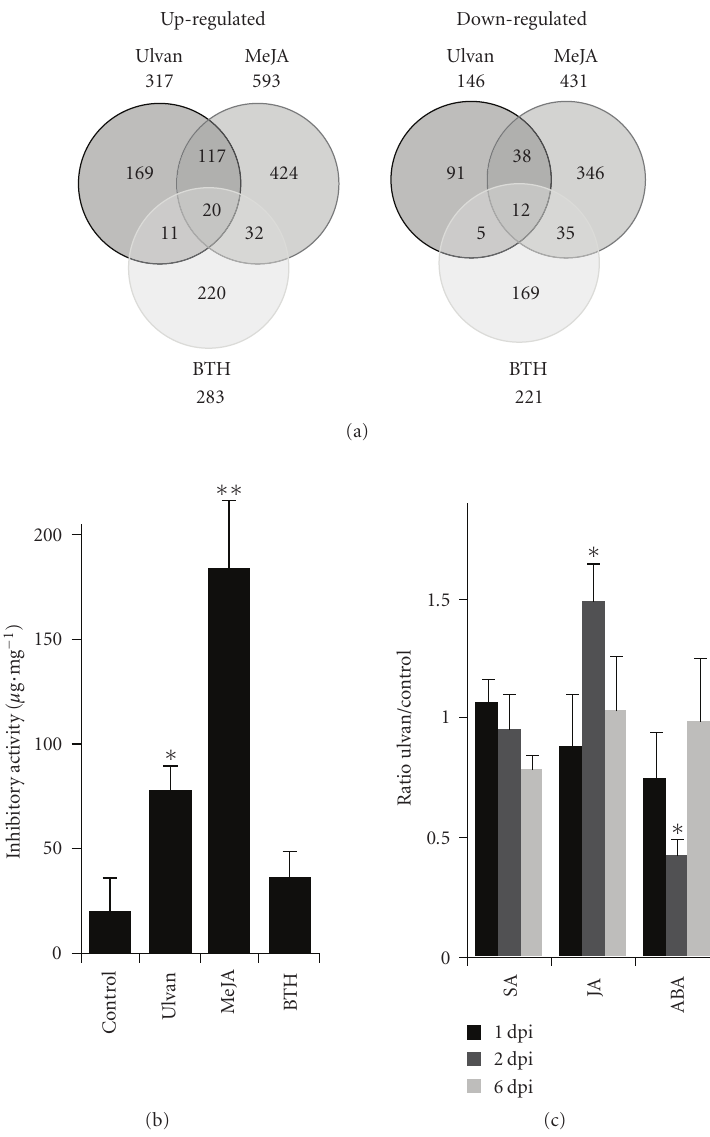
Figure 2: Comparison of M. truncatula transcriptomic responses to ulvan, BTH, and MeJA. M. truncatula plants were treated by ulvan (ethanol-insoluble fraction, 1 mg · ml − 1 ), MeJA (500 μ M), BTH (40 μ g · ml − 1 ), or Actilandes (0.01%) as the control. (a) Venn diagrams showing the total number of genes up-regulated (left) or down-regulated (right) upon ulvan, BTH, and MeJA treatments and their respective overlaps. Data obtained at 1–2 and 6 days after treatment are mixed. Only genes with a P -value ≤ . 05 and a | log(2) ratio | ≥ 0 . 584 were selected. (b) Trypsin protease inhibiting activity measured on M. truncatula leaves harvested 6 days after treatment. Activity is expressed as μ g of trypsin inhibited per mg of protein extracted from the leaves. The average of measures done on three biological replicates is represented. (c) Measurement of the SA, JA, and ABA contents of M. truncatula leaves harvested 1, 2, and 6 days after treatment using UPLC-ESI- MS/MS. Mean of the relative amount after ulvan treatment compared to Actilandes, used as control, was calculated from three experiments and represented on the graph. Mean for each treatment was compared to the control mean using a Student’s t -test. Treatment associated to a P -value ≤ . 05 or ≤ . 01 was marked, respectively, by ∗ or ∗∗